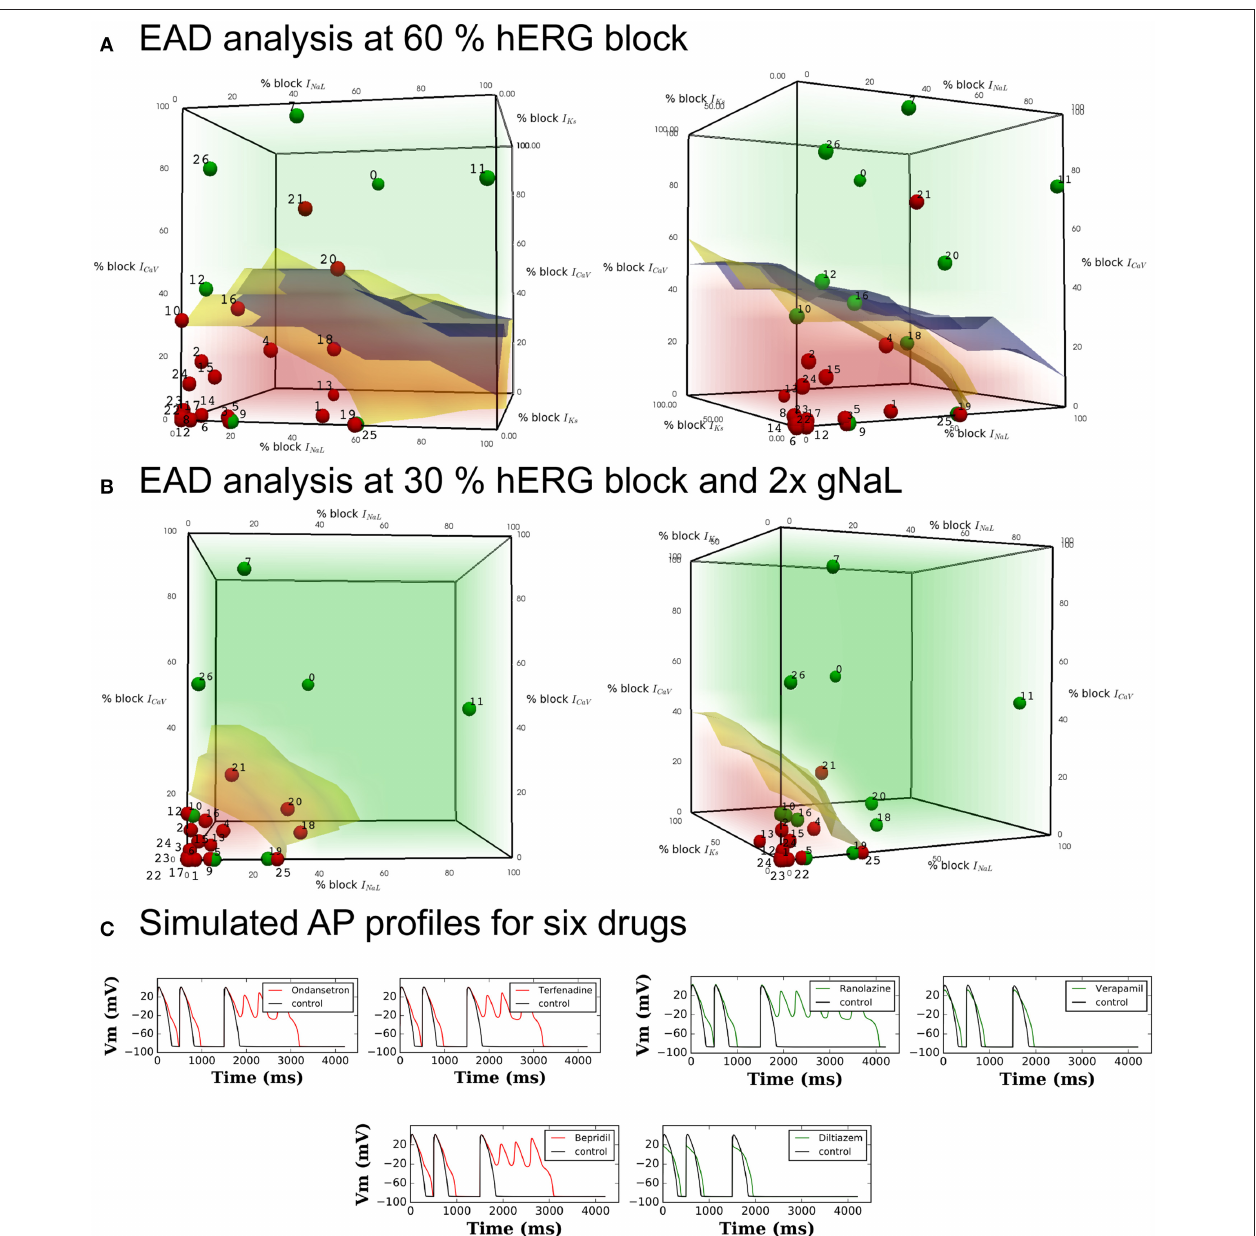
FIGURE 2 | Pause-induced EAD generation: combination of 0–100% I CaL , I NaL , and I Ks blocks tested at (A) 60% hERG block in the OHR and OHRmv (B) 30% hERG block in the OHRmv that is modified to simulate LQT3 through increase in late sodium current conductance by 2-fold. Red regions cover the set of combinations of the blocks of the three channels that induced EADs in the model. Green region covers the set of combinations where EADs did not appear. Blue and yellow surfaces represent the separation between the EAD + and EAD − region in OHR and OHRmv, respectively. The blue and yellow surfaces are plotted together in both plots in (A) to allow for easy comparision, but note that the red and green regions corresponds to the results for the OHR model. Block of I CaL , I NaL , and I Ks at drug concentrations equal to 60 and 30% hERG block are calculated from in-vitro patch-clamp data in Crumb et al. (2016) using (Equation 1) and represented as dots in the parameter space of (A,B) , respectively. The drugs with torsadogenic potential were plotted as the red dots, while drugs with no known torsadogenicity risk are plotted as the green dots for two different TdP definitions. Definition 1 (left panels) - TdP + : Drugs in R1, R2, R3, CH1, CM1 or torsade label. Definition 2 (right panels) - TdP + : Drugs in CM1 and CM2. The data points for the Dataset 5: 0-Amitriptyline, 1-Azithromycin, 2-Bepridil, 3-Chloroquine, 4-Chlorpromazine, 5-Cibenzoline, 6-Cisapride, 7-Diltiazem, 8-Dofetilide, 9-Flecainide, 10-Lopinavir, 11-Mexiletine, 12-Mibefradil, 13-Moxifloxacin, 14-Nilotinib, 15-Ondansetron, 16-Propafenone, 17-Quinidine, 18-Quinine, 19-Ranolazine, 20-Ritonavir, 21-Saquinavir, 22-Sertindole, 23-Sotalol, 24-Terfenadine, 25-Toremifene, 26-Verapamil. Three drugs (Amiodarone, Lidocaine and Rufinamide) with hERG ratio greater than 200 were not included in the plot. (C) Transient AP profiles at 200th beat obtained from simulation of six drugs in the OHR model. Red and green traces show that the drug is defined as TdP + and TdP − , respectively.